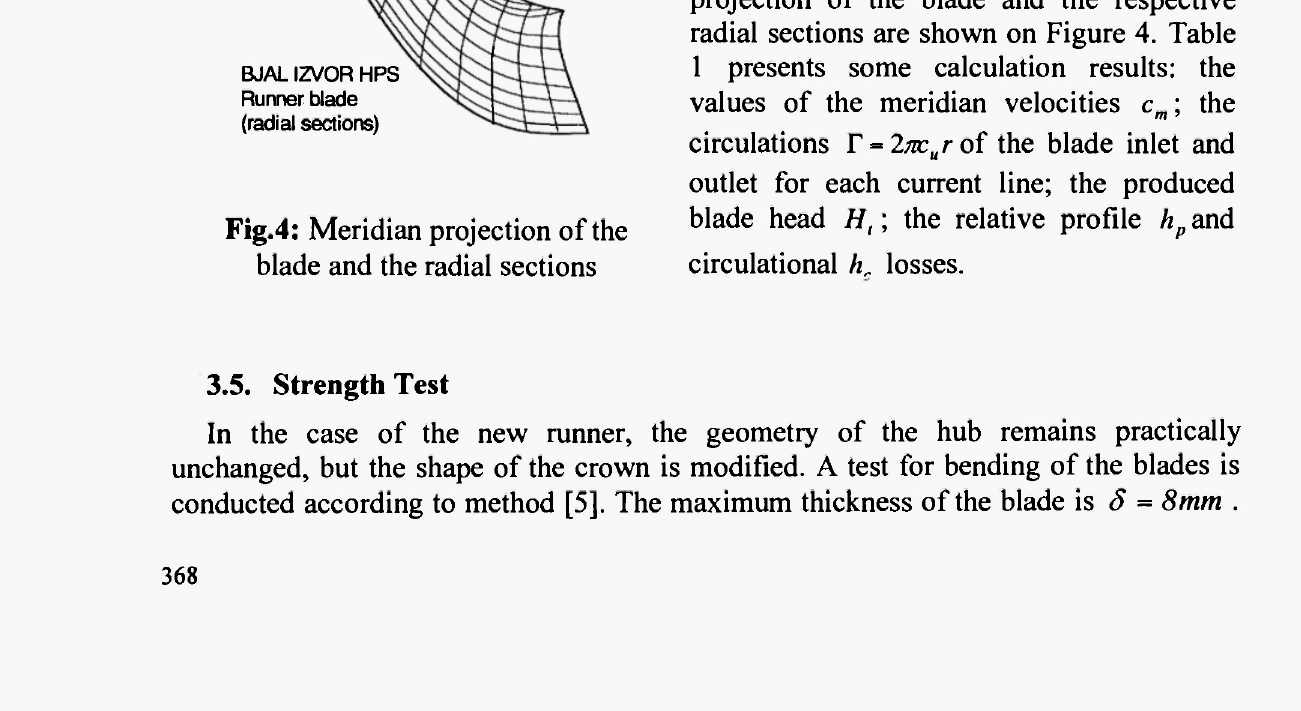
Fig.3: Distribution of the relative velocity and the pressure